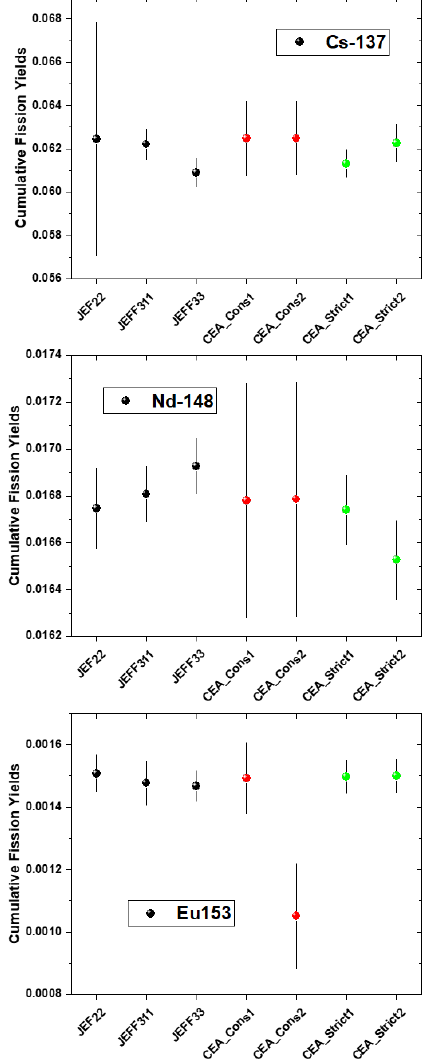
Fig. 23. Comparison of current evaluations for three important heavy chain yields.